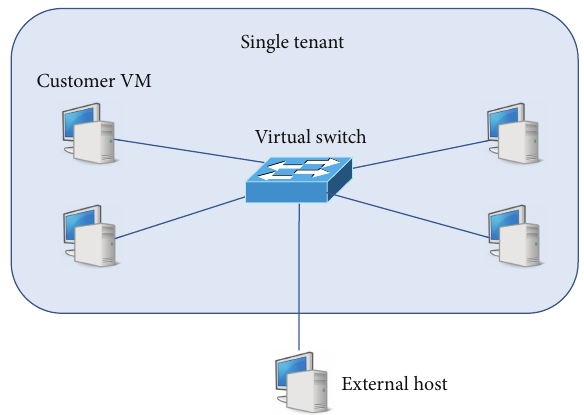
Figure 4: Reference logical architecture of a single tenant virtual infrastructure with 5 hosts: 4 hosts are implemented as VMs in the cloud and are interconnected via the OpenStack layer 2 virtual infrastructure; the 5th host is implemented by a physical machine placed outside the cloud but still connected to the same logical LAN.